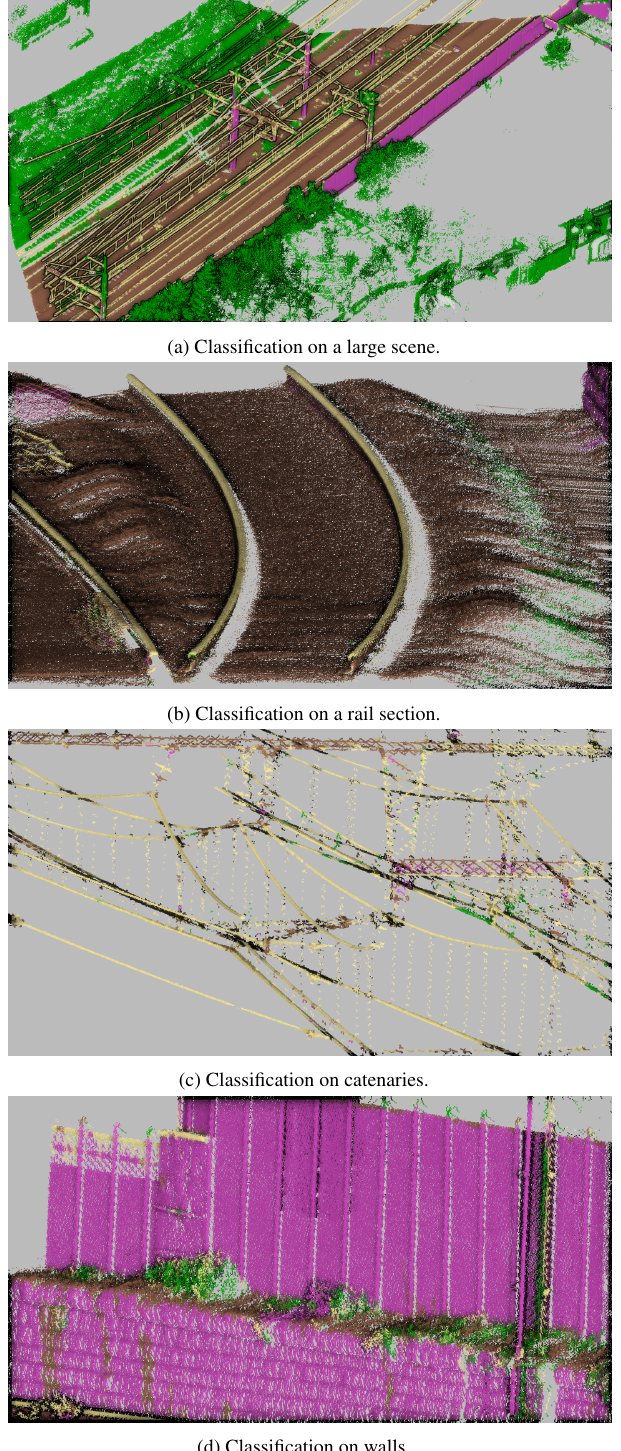
Figure 4. Classification results for 5 classes: vegetation (green), ballast (brown), linear objects (yellow), walls & fences (pink) and other (white). The results are obtained after a pre-segmentation step and a regularization on 20 neighbors. The scenes show respectively a view of a 100m × 100m tile containing 3.4 million points, and close-ups on rail tracks and ballast (4b), a complex set of catenaries (4c) and sidewalls (4d).